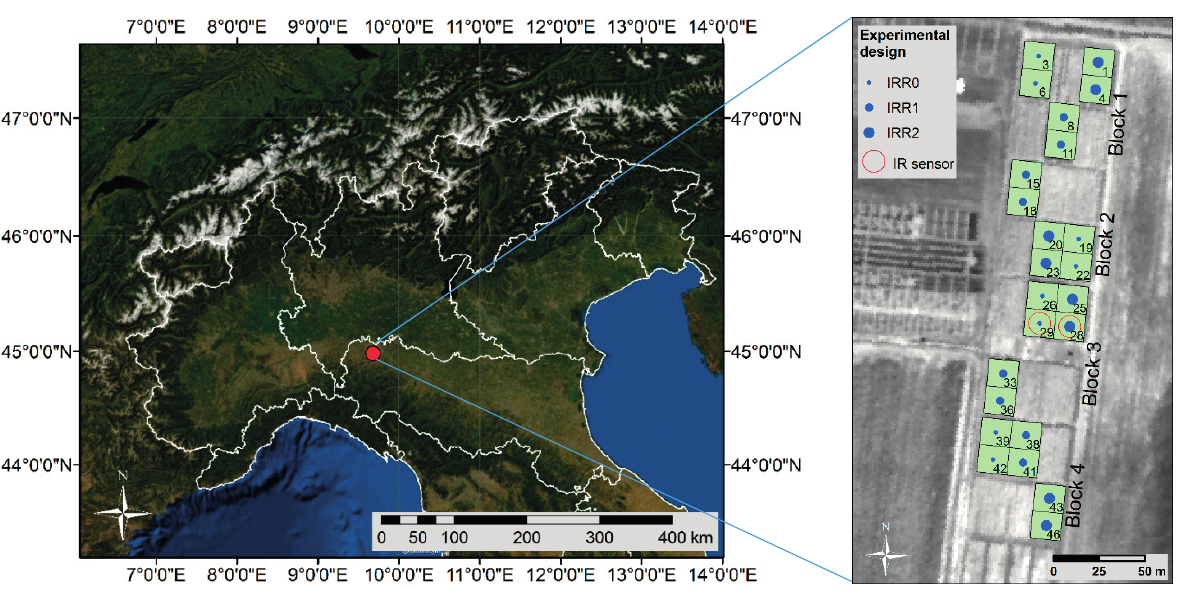
Figure 1. Experimental field location in Northern Italy and treatment scheme. The irrigation levels are shown as small circles in rainfed plots (Irr0), medium circles in water deficit plots (Irr1) and large circles in full irrigation plots (Irr2). Red circles indicate the position of the two infrared radiometer sensors in the maize